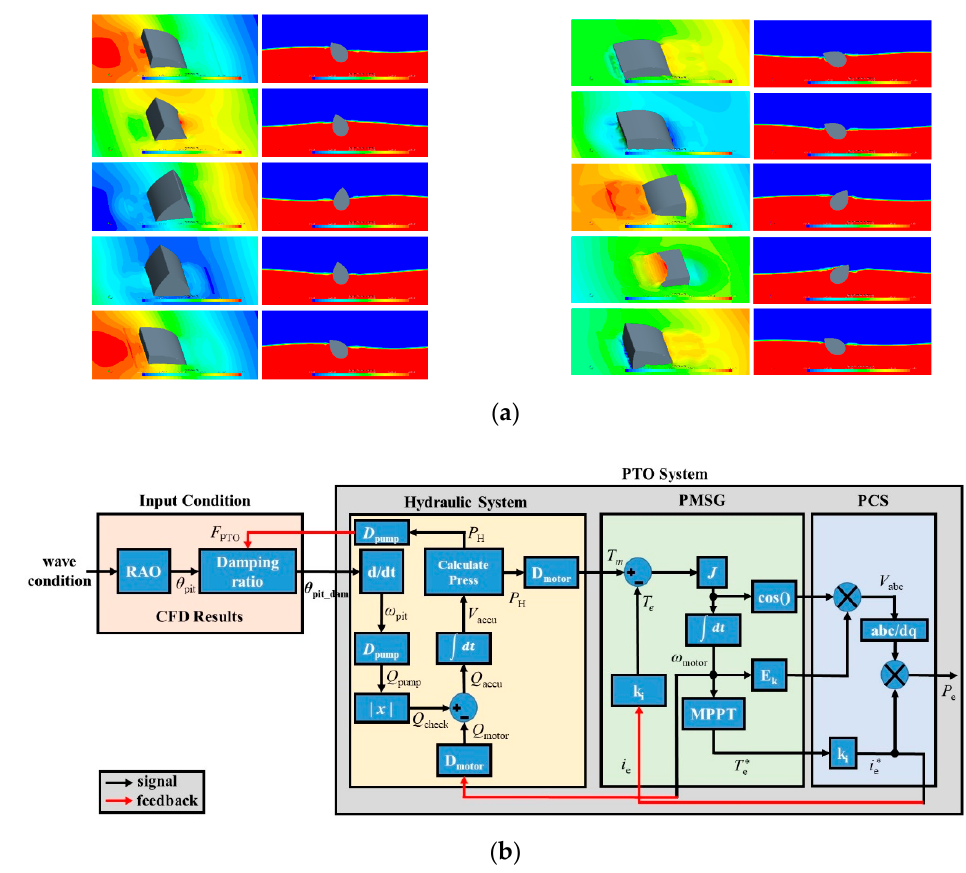
Figure 8. ( a ) CFD analysis plot for input conditions [37]. ( b ) Simulation block diagram for comparison of load control algorithm performance.